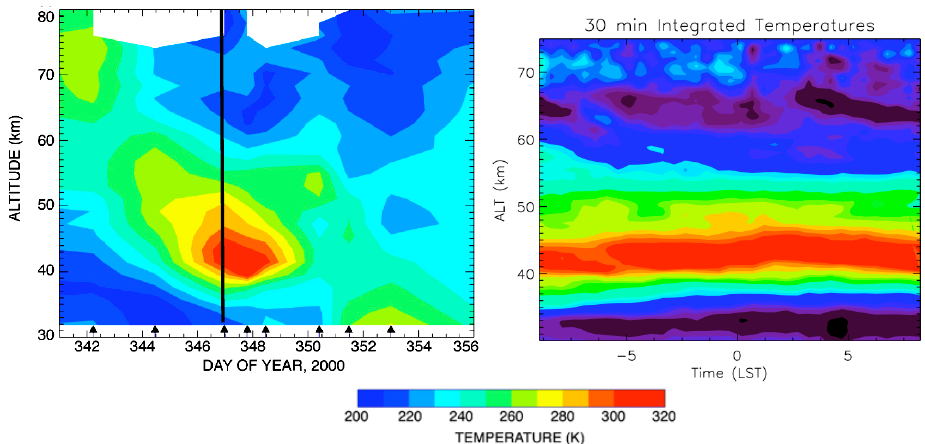
Fig. 2. From Thayer and Livingston (2008). Evolution of middle atmospheric temperatures over Sondrestrom, Greenland in December 2000 as measured by the molecular / aerosol lidar system. The vertical black line represents the day under study herein. (right) Range-time temperature evolution over Sondrestrom over the day near the estimated peak STE represented by the vertical black line (i.e., day of year